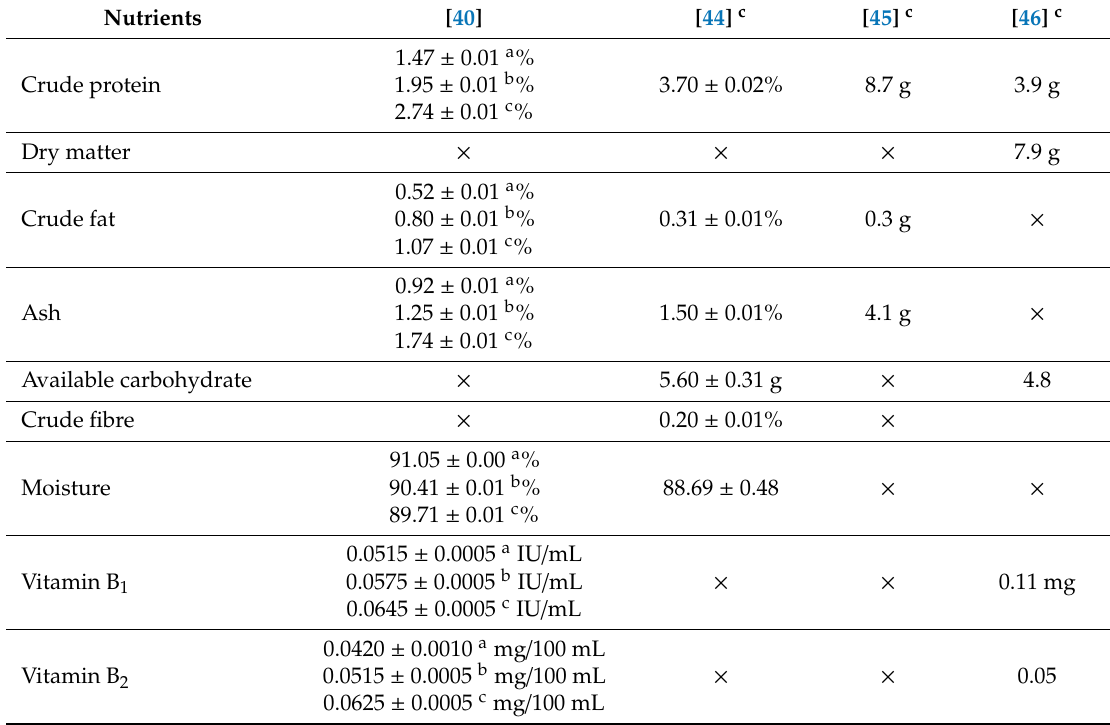
Table 1. Nutritional composition of pito according to the